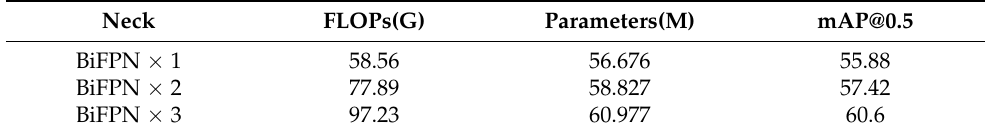
Table 3. Results on different numbers of BiFPN modules.